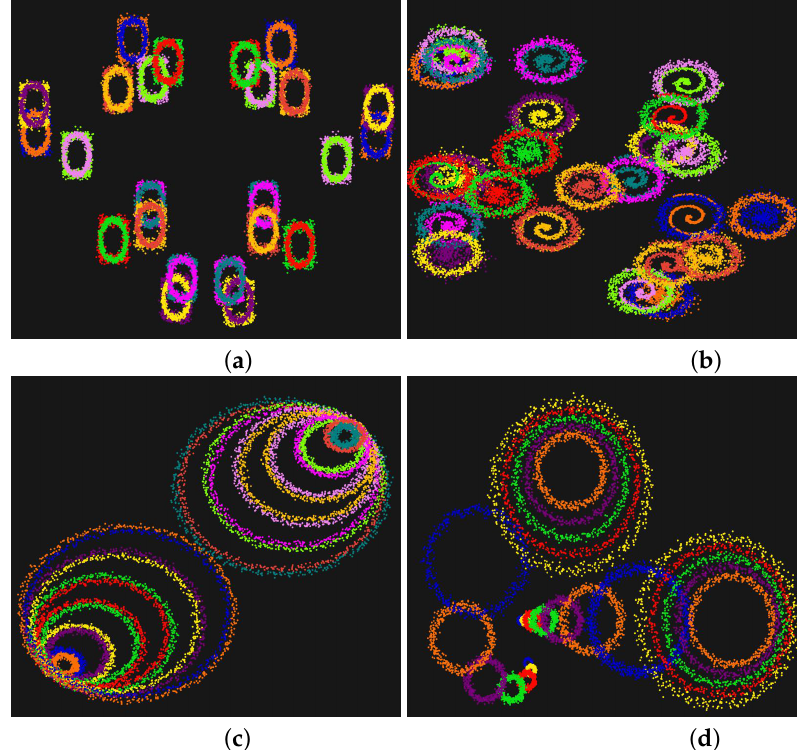
Figure 4. Four different stigmergic color-symmetric patterns with isometric as well as color symmetry. ( a ) Vertical reflection ( b ) Archimedean spirals with color-symmetric counterpart obtained by a rotation about a random center point. ( c ) Diagonal reflection ( d ) Circle symmetry following a Fibonacci circle curve.